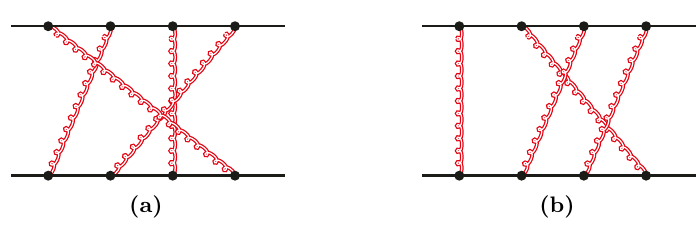
Figure 13. Diagrammatic representation of the terms on the right hand side of eq.